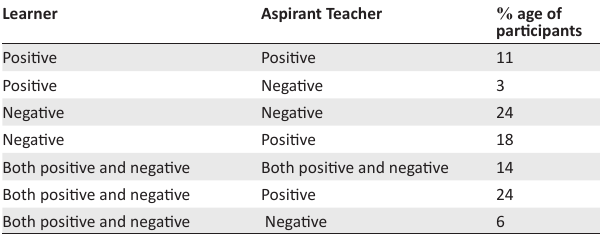
TABLE 5: Comparative analyses of participants’ attitudes as learners vs. teachers of mathematics. (Attitude shifts in roles as learners of mathematics to being aspirant teachers of mathematics in the Foundation Phase)